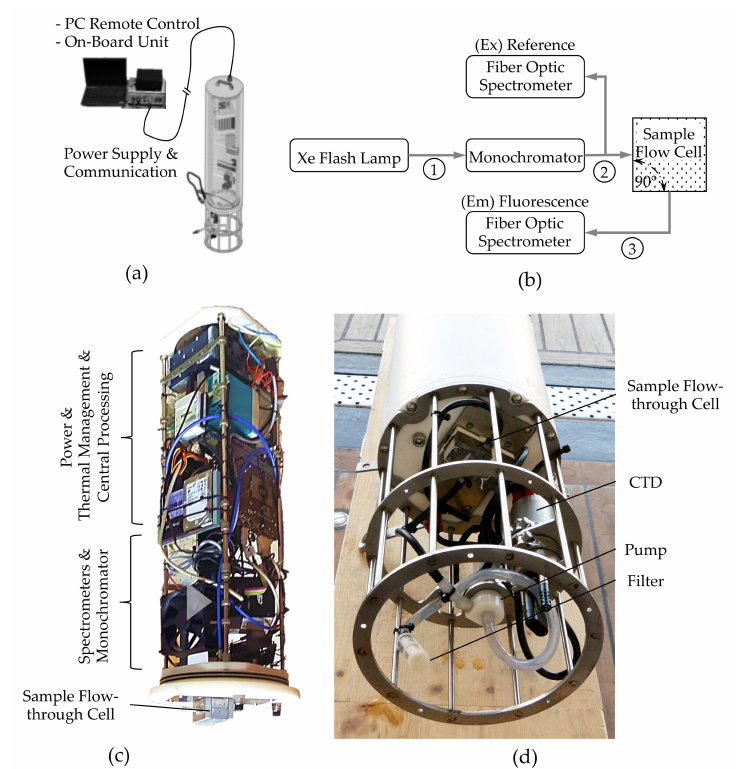
Figure 2. System components of the submersible EEMS sensor system. ( a ) System connected to an on-board unit and remote PC-control (optional). ( b ) Schematic structure of excitation–emission matrices (EEM) fluorescence spectrometer hardware and optical components (connected by optical fibers 1, 2, 3). ( c ) Internal close-up with electronics and optical components. ( d ) Close-up of the outer components of the EEMS sensor